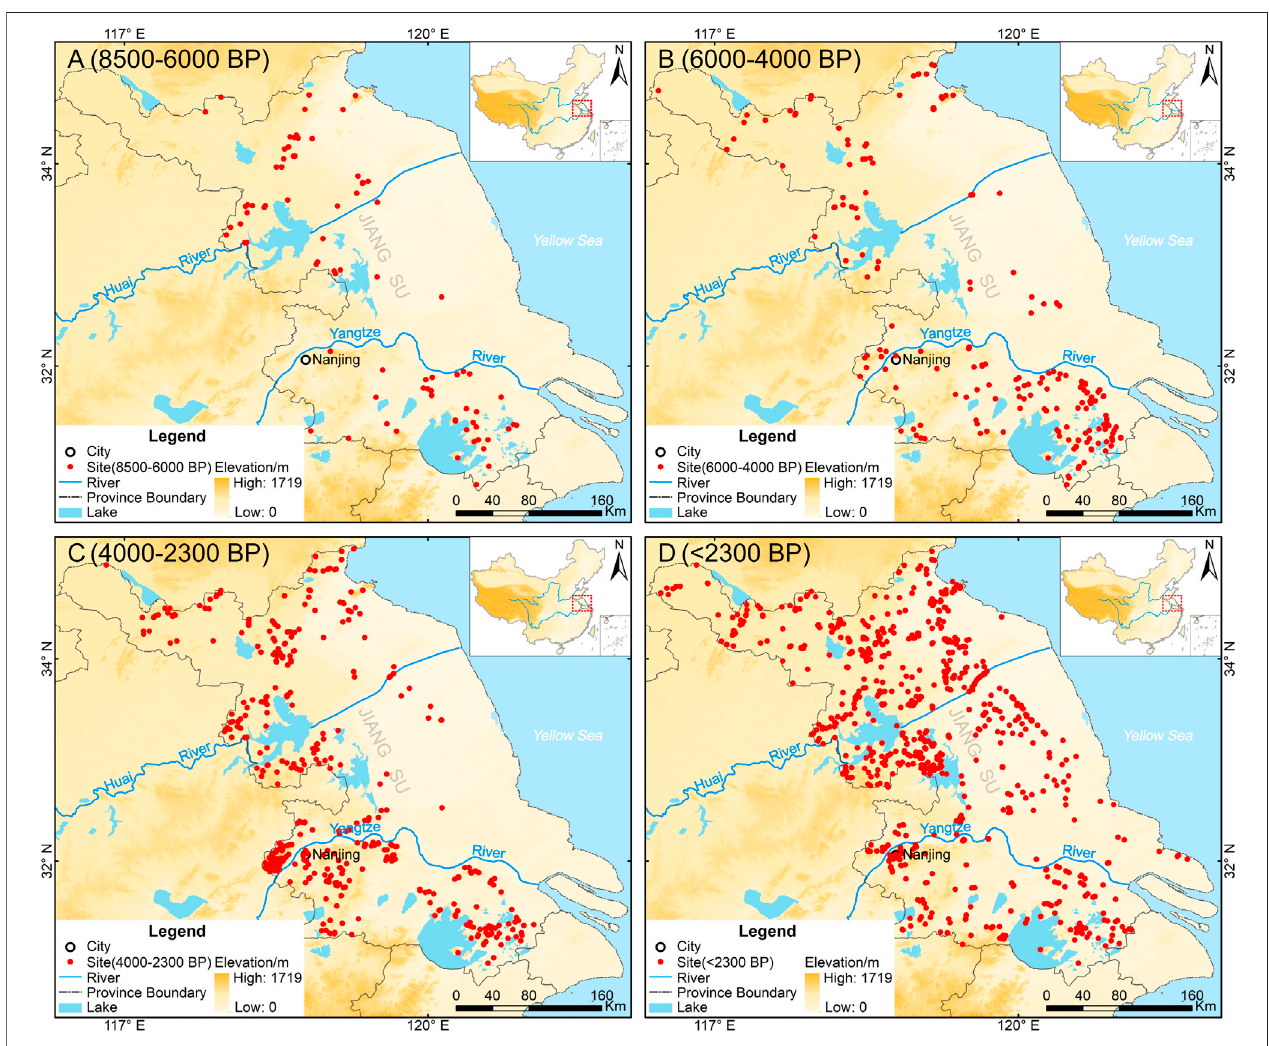
FIGURE 2 | The distribution of archaeological sites since in Holocene in Jiangsu